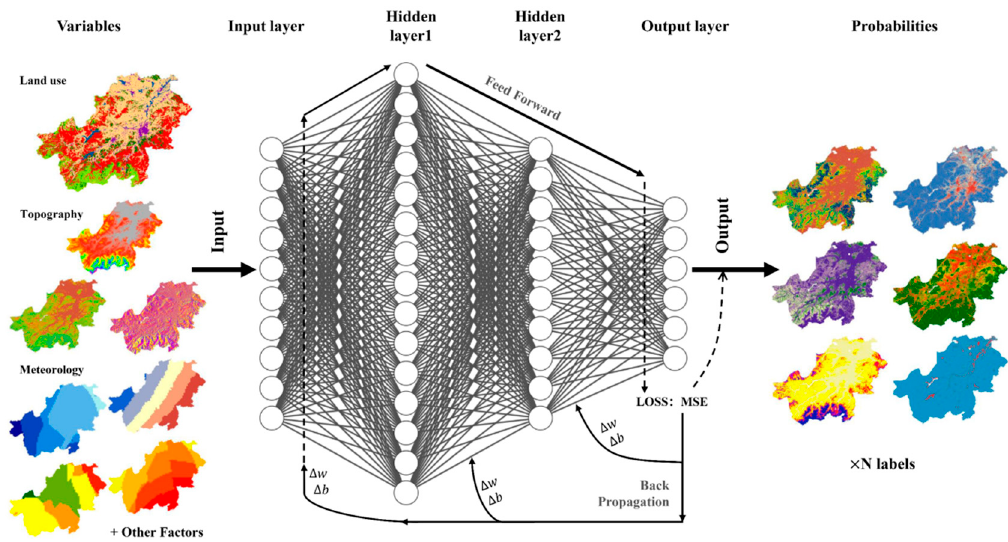
Figure 3. The structure of the back propagation neural network (BPNN).